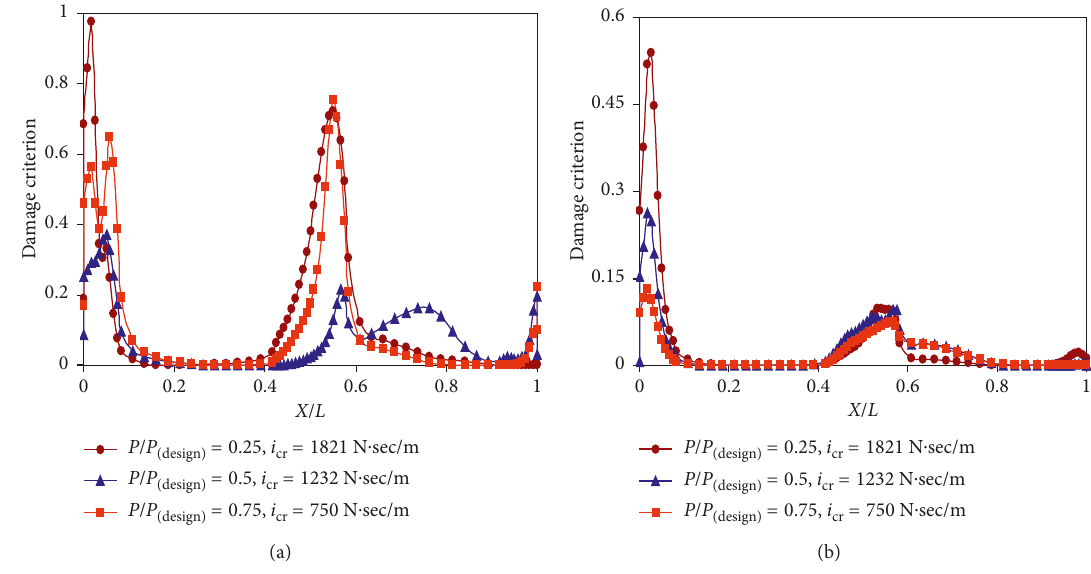
Figure 15: Damage initiation criterion profile of propped cantilever column W150 of the tension flange; (b) at the middle of the